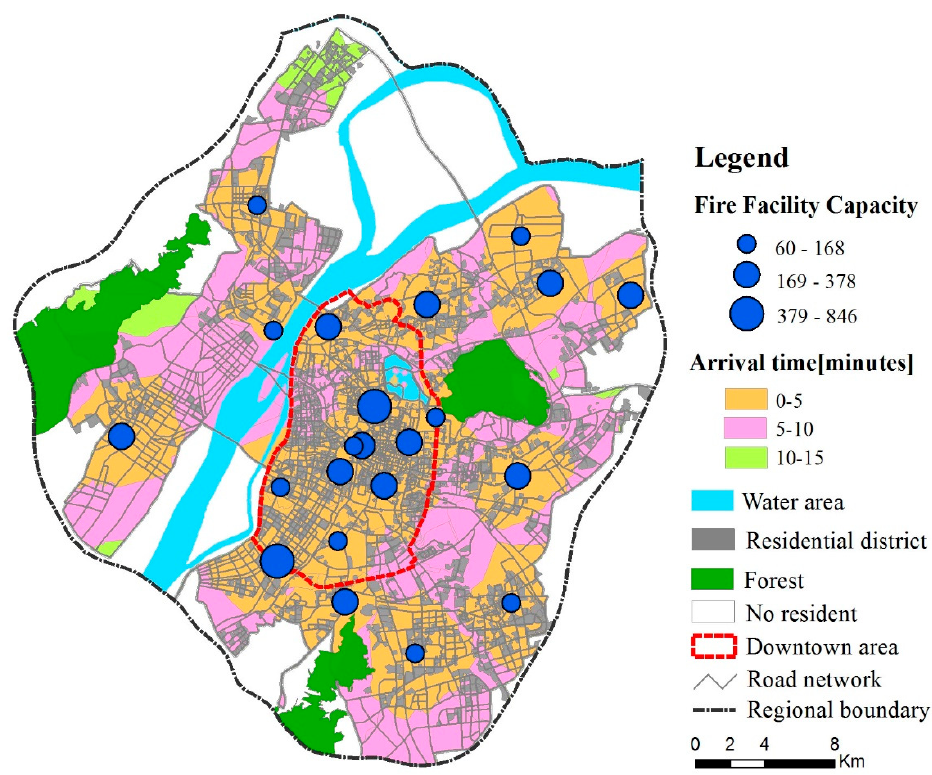
Figure 3. Spatial difference of fire service time accessibility in the study area.